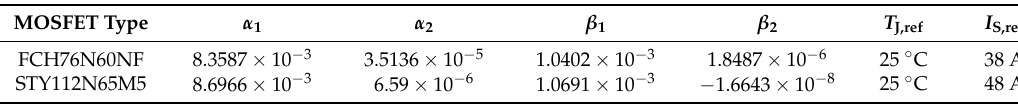
Table A3. Coefficients ( α 1 , α 2 and β 1 , β 2 ) and values for T J,ref and I S,ref , required to evaluate (23) for the used MOSFETs.